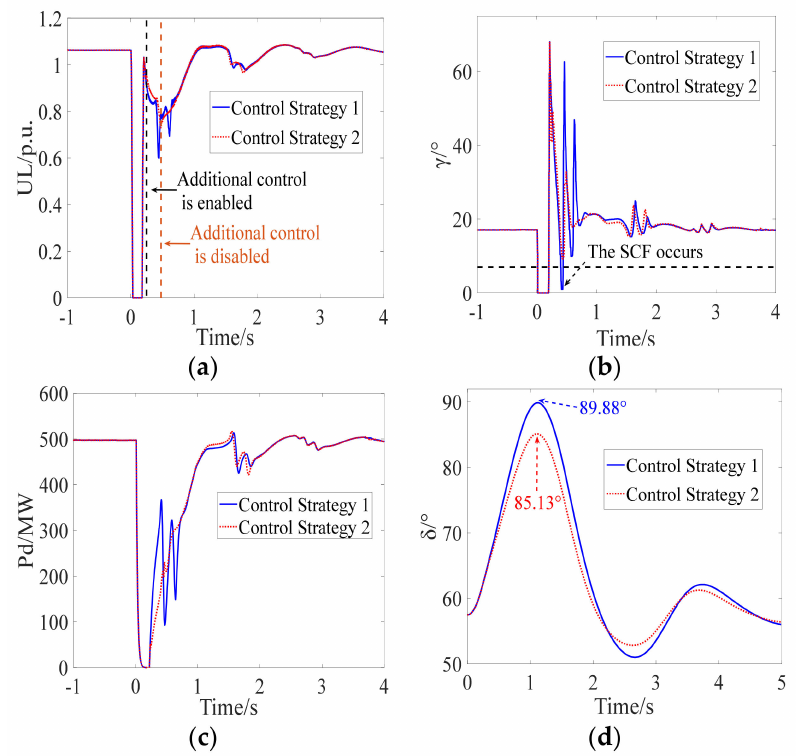
Figure 13. Simulation results of Scenario 1. ( a ) Inverter bus voltage, ( b ) extinction angle, ( c ) DC power, and ( d ) relative rotor angle.